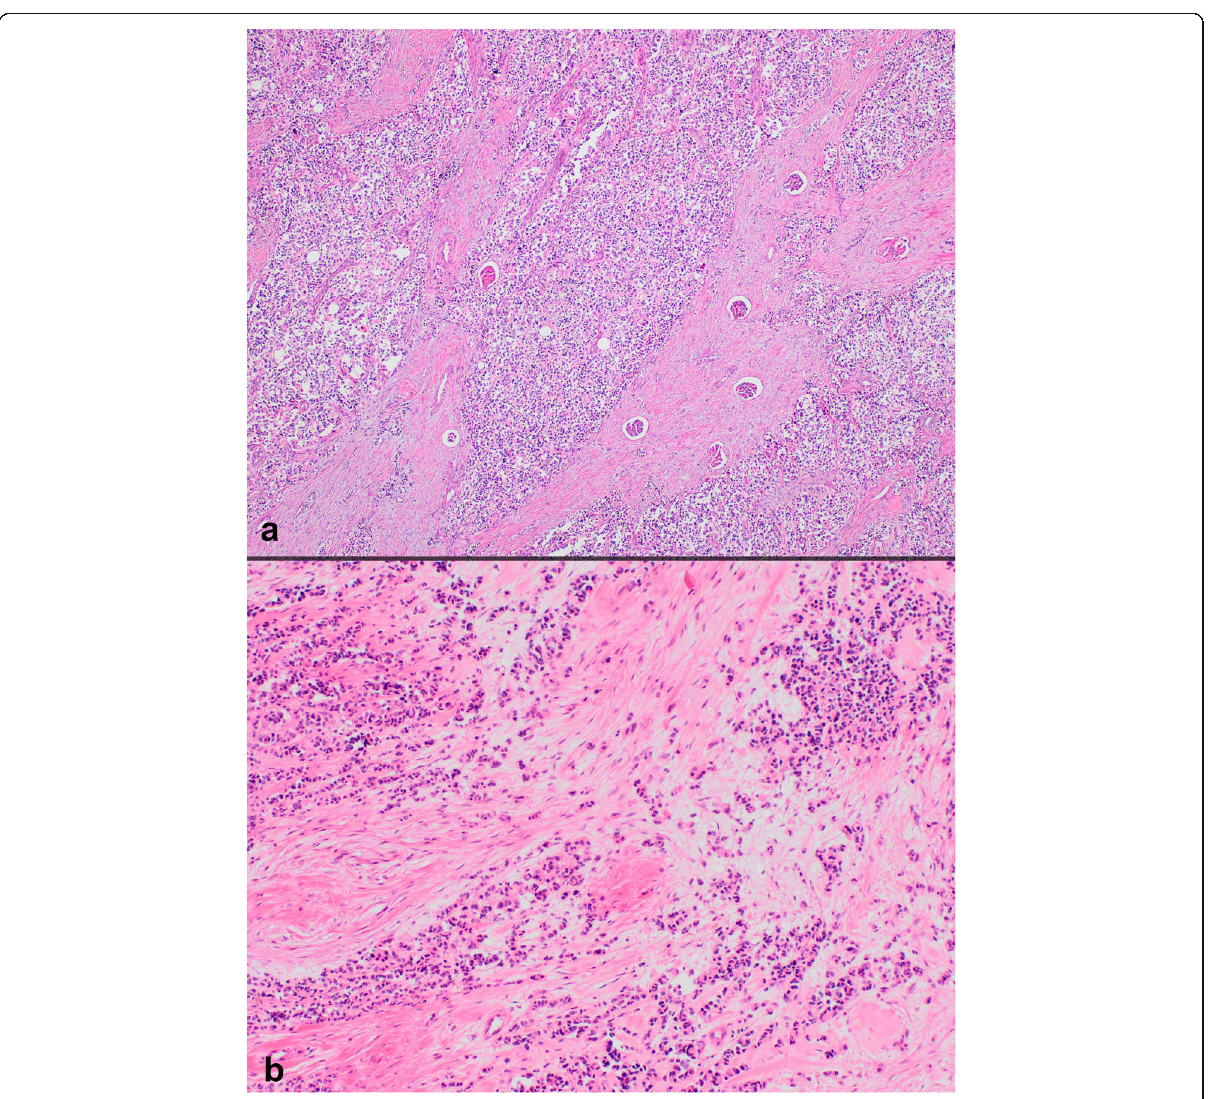
Fig. 1 Sheets, nests and cords of neoplastic cells in a desmoplastic stroma ( a H&E × 40; b H&E ×